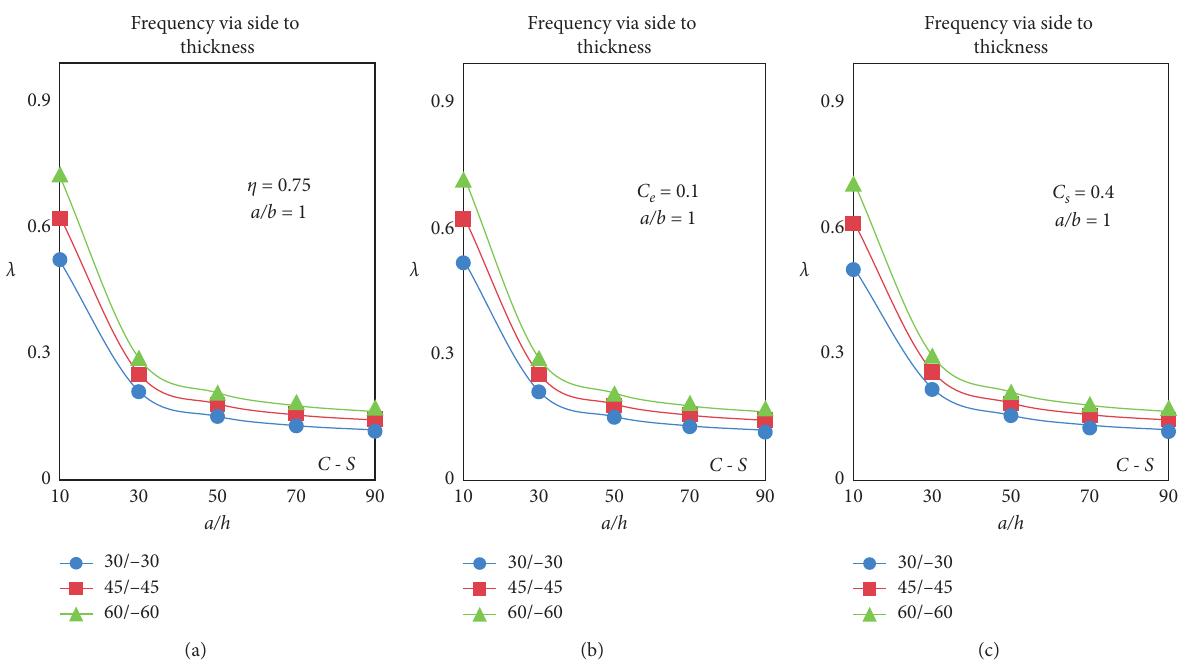
Figure 4: Impact of side-to-thickness ratio on frequency parameter value of 2-layered plates: EGE.